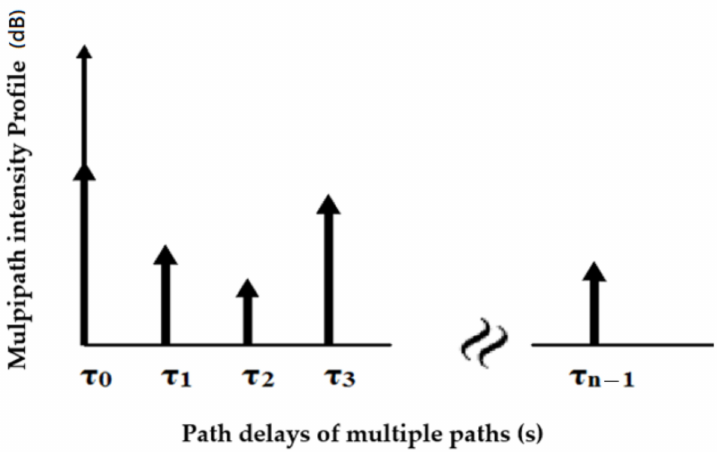
Figure 2. Schematic diagram of receiving point affected by multipath